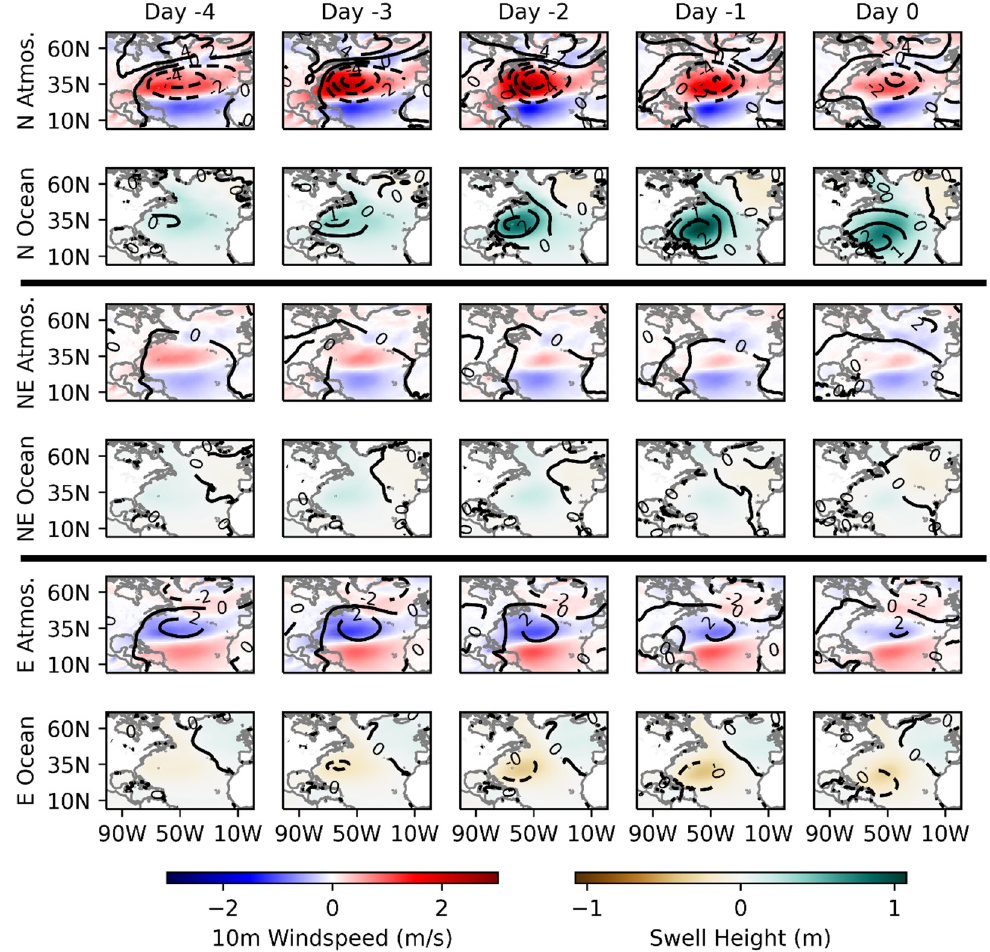
Figure 10. Atmosphere (rows 1, 3, and 5) and ocean swell (rows 2, 4, and 6) anomaly composites for the north cluster (rows 1–2; 1092 days composited), northeast cluster (rows 3–4; 2517 days composited), and east cluster (rows 5–6; 3401 days composited). Anomalies are composite average differences from the climatological mean atmosphere and ocean swell maps presented in Figure 9. Shading is the surface wind speed or ocean swell height anomaly. Contours are the sea level pressure (hPa) or ocean swell period (s) anomaly. Anomalies of surface wind and swell directions are not shown. Day 0 is the day that was classified as belonging to one of the three clusters. Days − 1 to − 4 represent the 4 days prior to Day 0.